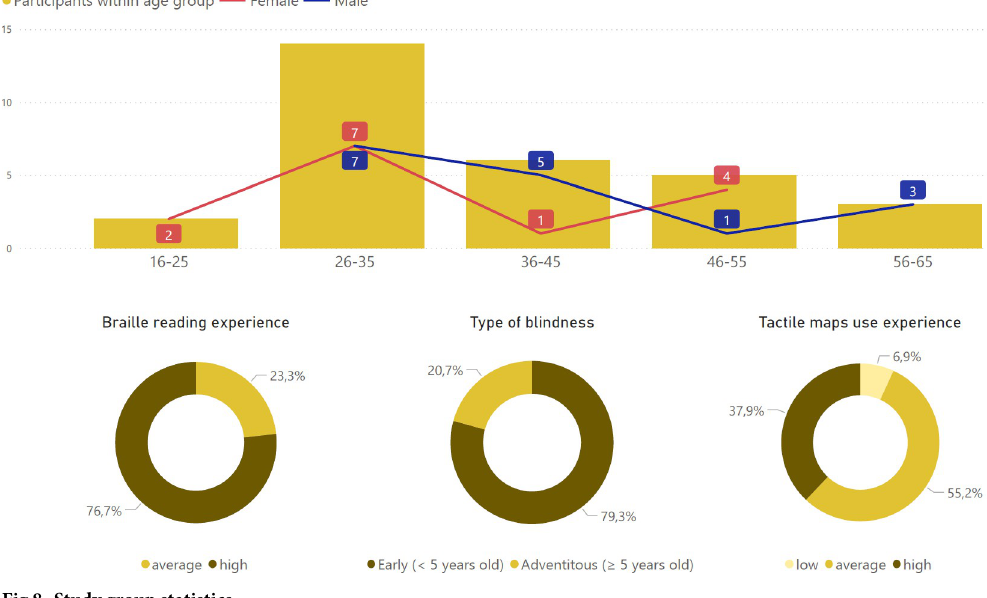
Fig 8. Study group statistics.